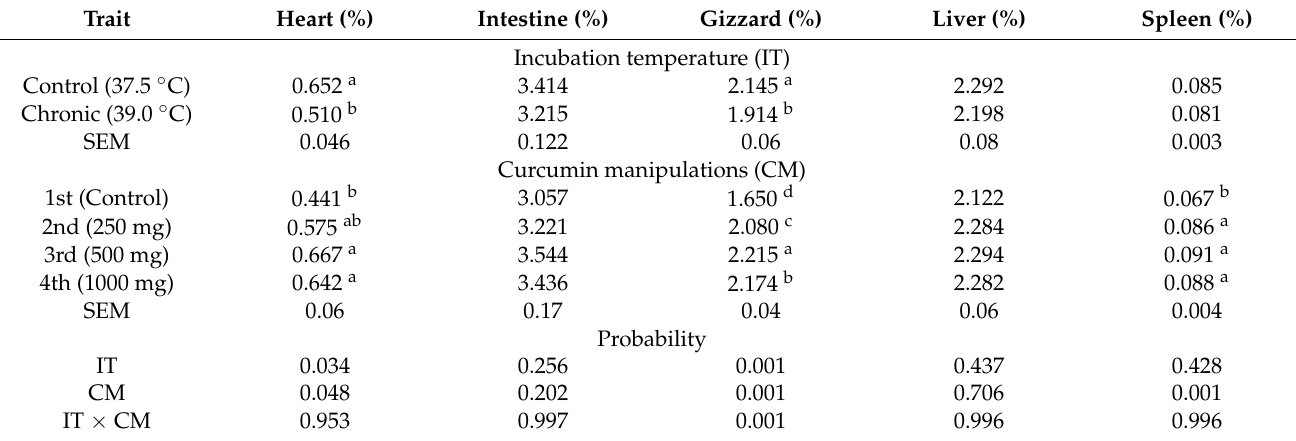
Table 3. Impact of incubation temperature, curcumin manipulations and their interaction on hatchling organ percentage.